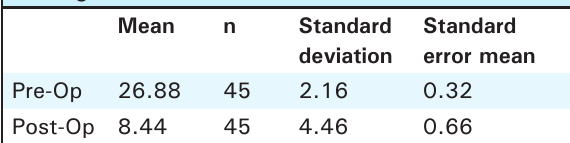
Table 2. Comparision of Pre and Post-operative hearing.